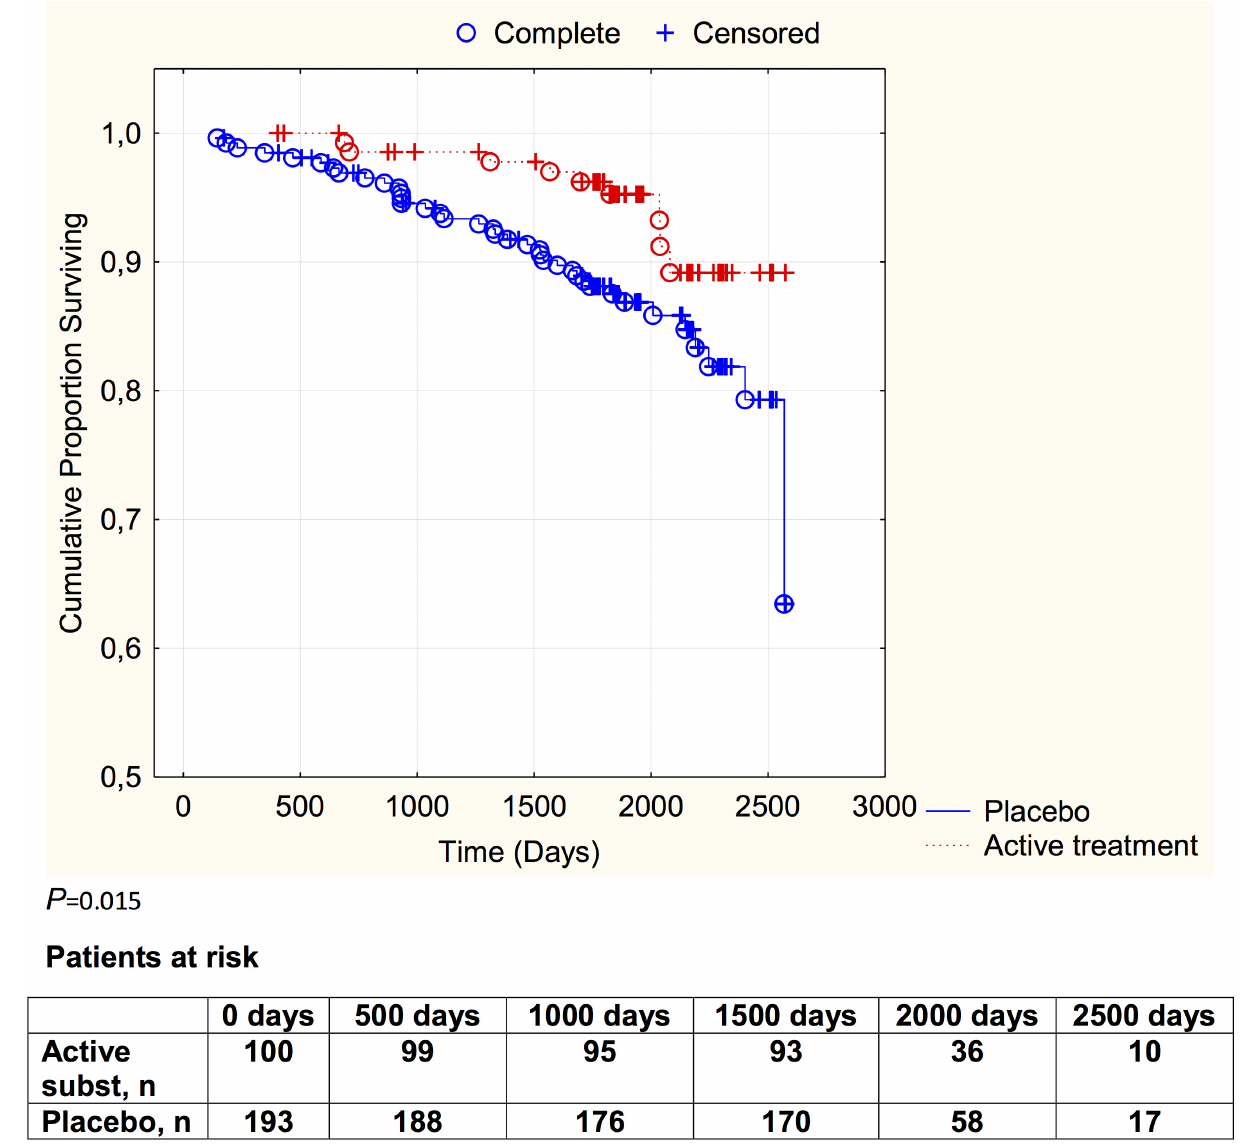
Fig 4. Kaplan-Meier graph illustrating cardiovascular mortality in the study population with a plasma selenium concentration of 65 – 85 μ g/L divided into those given selenium and coenzyme Q10 combined versus those given placebo or no treatment during a follow-up period of 5.2 years. Censored: patients who were still alive at the end of the follow-up period, or who died from non-cardiac causes.